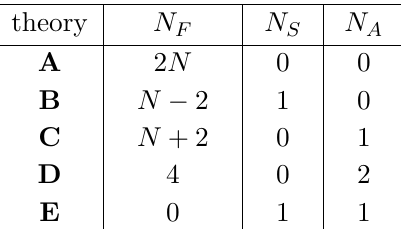
Table 1 . The (cid:12)ve families of = 2 superconformal theories with SU( N ) gauge group and matter N in fundamental, symmetric and anti-symmetric